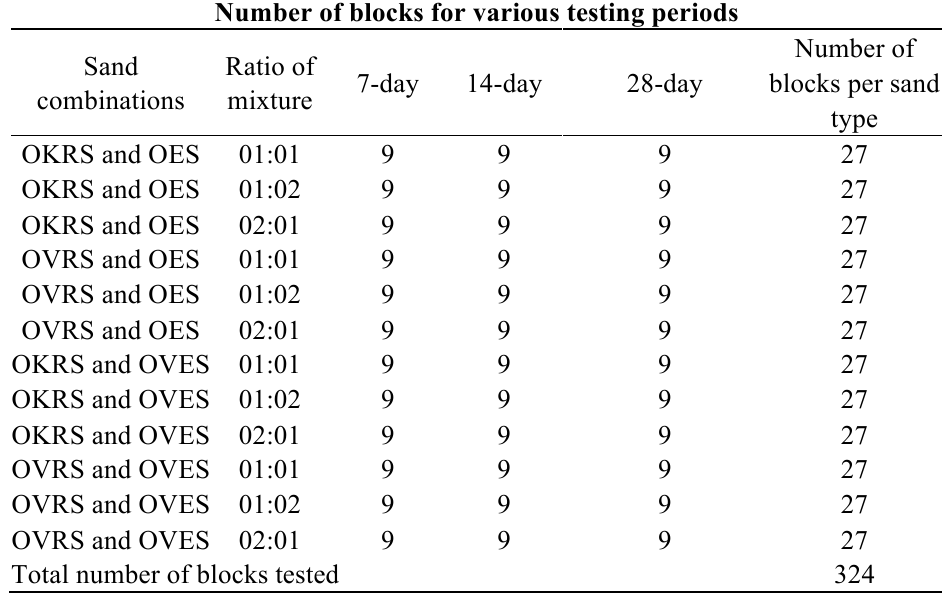
Table 3. Number of 150 mm sandcrete blocks from sand combinations for various testing periods and vibration